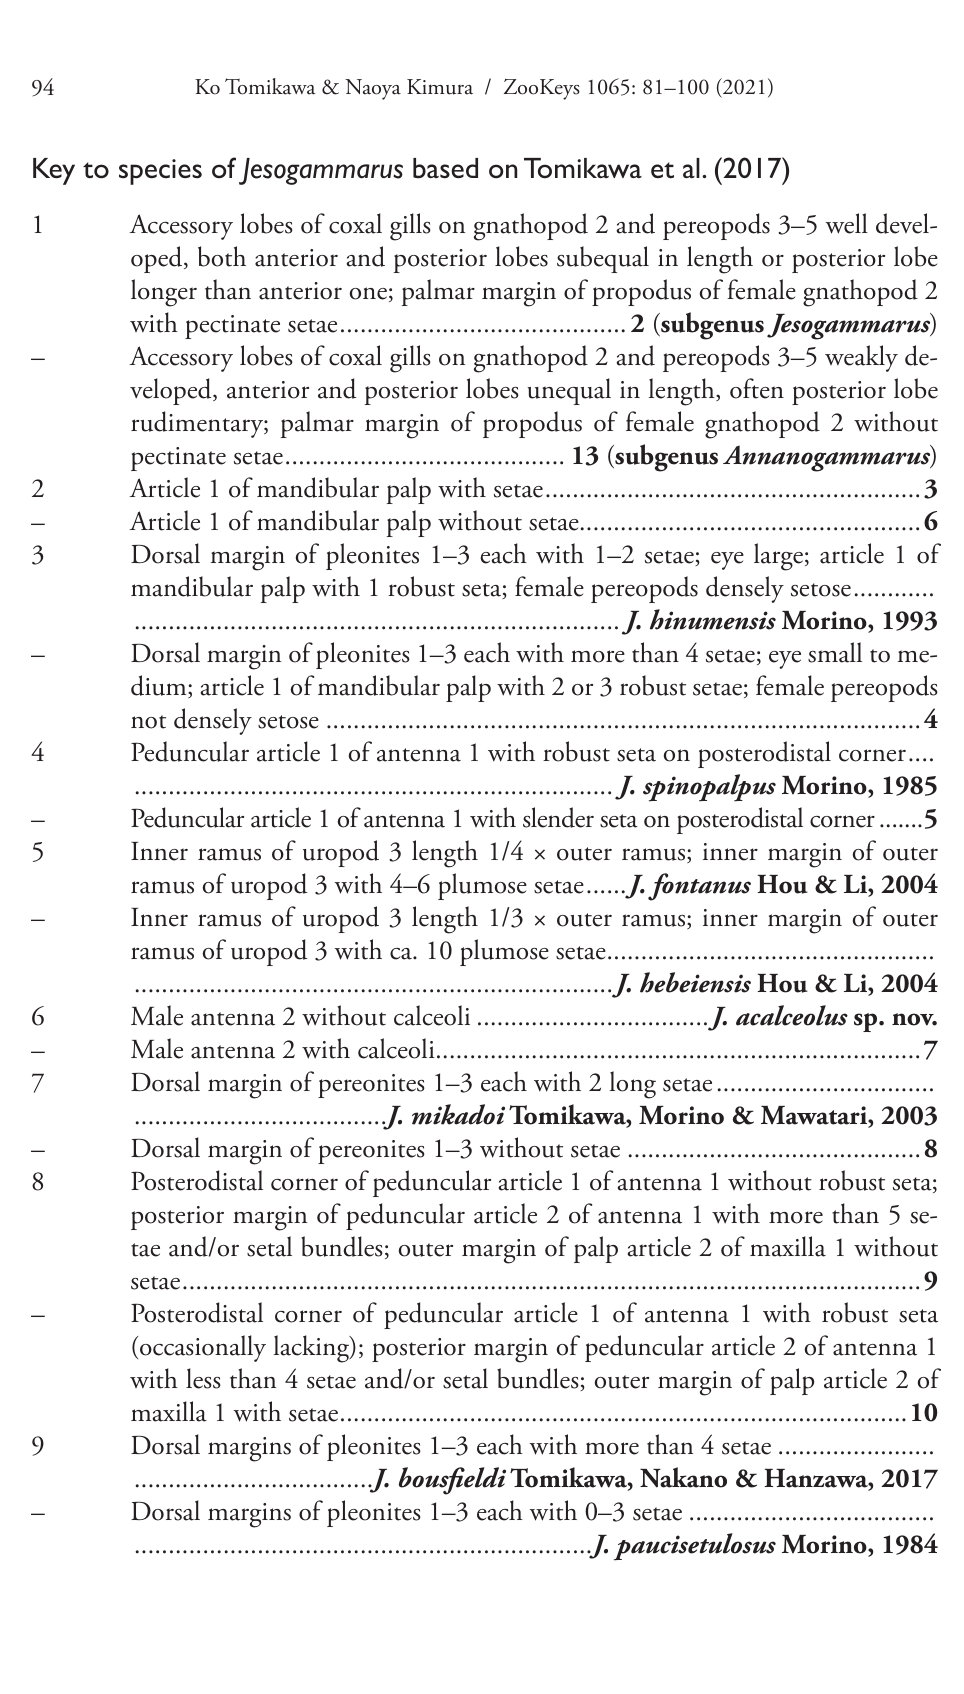
– Dorsal margins of pleonites 1–3 each with 0–3 setae